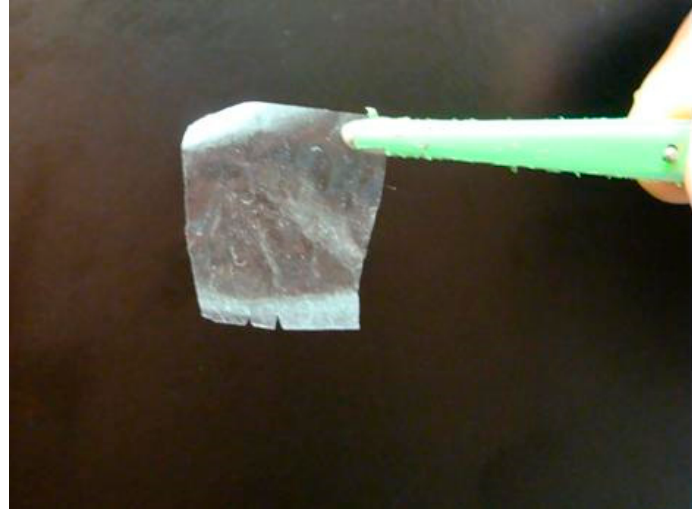
Figure A2. SEM cross-section images of ( a ) PDDA-Laponite 80 layers, ( b ) PDDA-Laponite 360 lay- ers, ( c ) PDDA-PSS-PDDA-Laponite 80 layers, ( d ) PDDA-PSS-PDDA-Laponite 180 layers, ( e ) PDDA- PAA-PDDA-Laponite 80 layers, and ( f ) PDDA-PAA-PDDA-Laponite 180 layers. Lines with arrows indicate the thickness of the film deposited on the substrate.